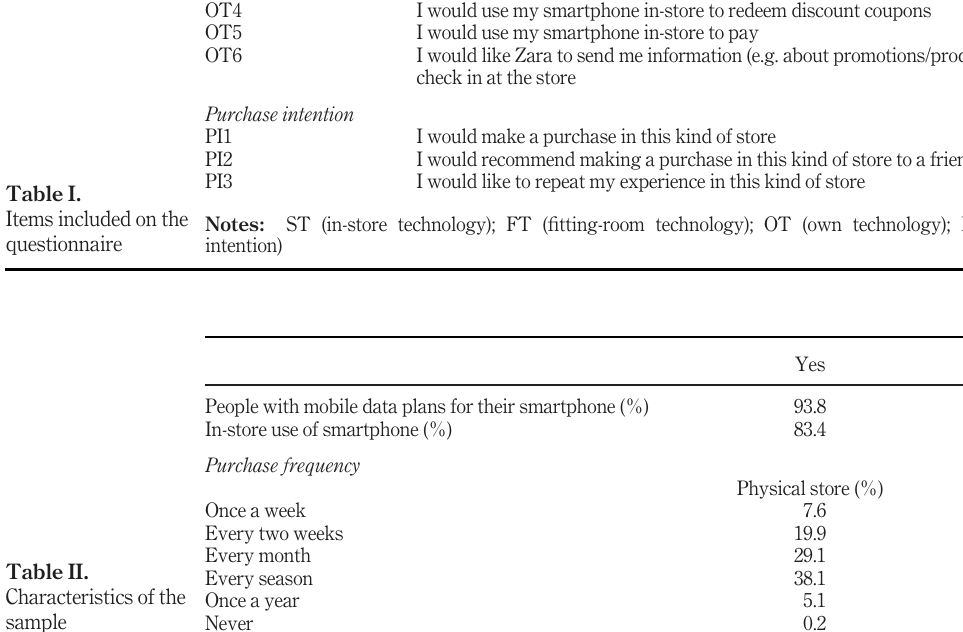
Table II. Characteristics of the sample